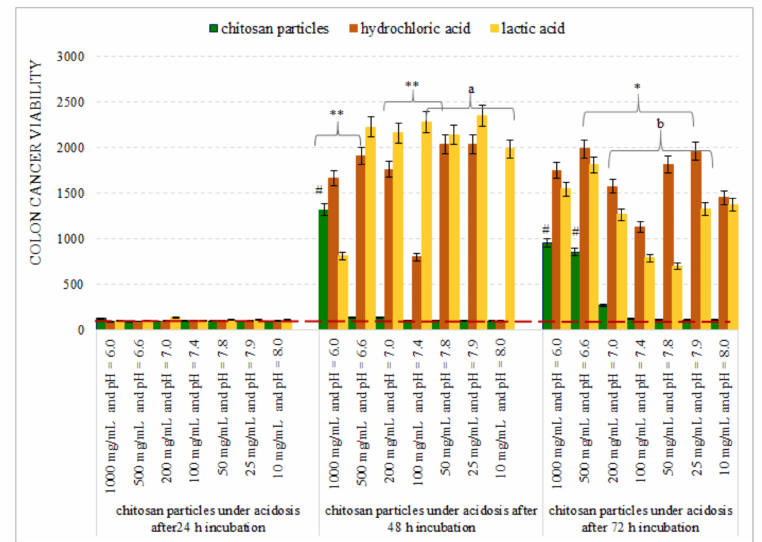
Figure 5. The effect of chitosan microparticles on the proliferative activity and viability of a colon cancer cell line incubated in a medium with pH-corrected values for 24, 48, and 72 h. The red line indicates the viability of colon cancer cells at the beginning of the experiment. Two levels of statistical significance between pH values adjusted by hydrochloric acid (* p < 0.05 and ** p < 0.01) or lactic acid (a < 0.05 and b < 0.01) were determined between the different applied concentrations of chitosan particles. The levels of statistical significance (# p < 0.01) in the experiments with chitosan particles were determined.